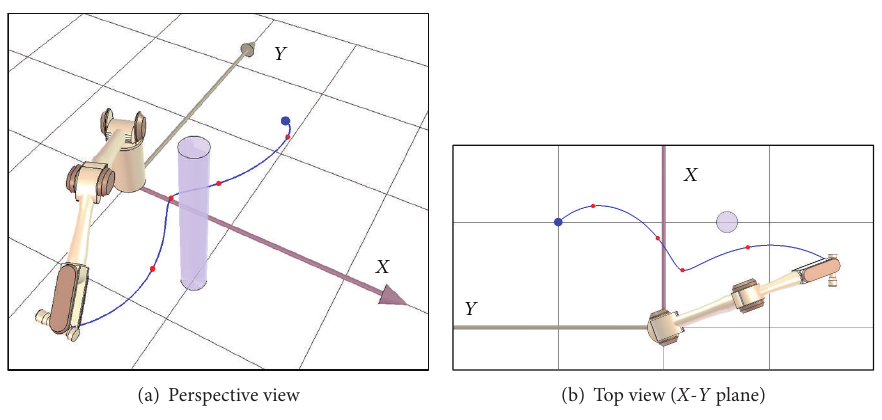
Figure 6: Motion path of example case of translation